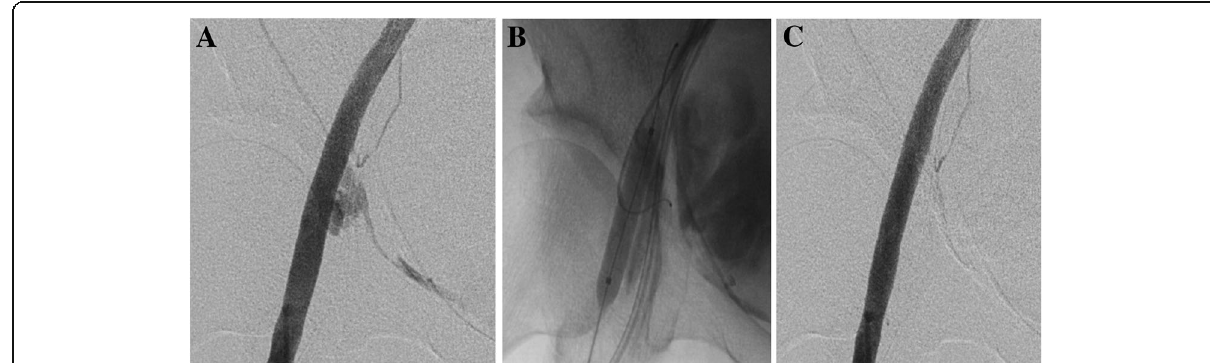
Fig. 1 52-year-old female patient with right external iliac arterial (EIA) bleeding. a Pre-treatment arteriogram demonstrates active extravasation from the right EIA just below the inguinal ligament level. b A microcatheter was advanced into the extravasation and injection of 1.0 ml of the NBCA-Lp mixture (ratio of NBCA to Lp; 1:2) was performed via the microcatheter under an 8-mm-diameter × 4-cm-length angioplasty balloon inflation. c No extravasation of contrast medium is seen on the arteriography performed immediately after